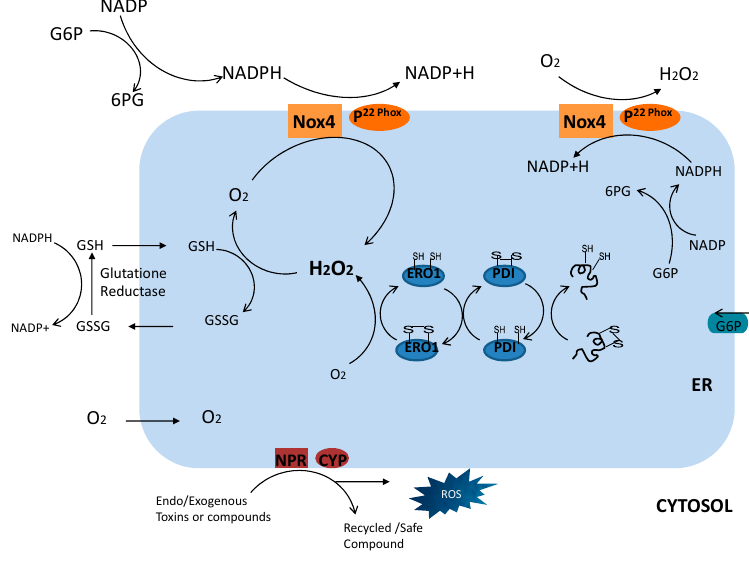
Figure 1. Depiction of endoplasmic reticulum (ER) redox communication by mediators. During the protein folding process, production of reactive oxygen species (ROS) by possible surrounding sources, such as NADPH oxidase 4 (Nox4), NADPH-P450 reductase (NPR), and GSH topologies, along with their functions in the outer ER environment. NADPH, Nicotinamide adenine dinucleotide phosphate; G6P, glucose-6-phosphate; 6PG, 6-phospho gluconate; Nox4, NADPH oxidase 4; GSH, glutathione; GSSG, glutathione disulphide; ERO1, ER oxidoreductin 1; PDI, protein disulfide isomerase. CYP/p450; Cytochrome p450